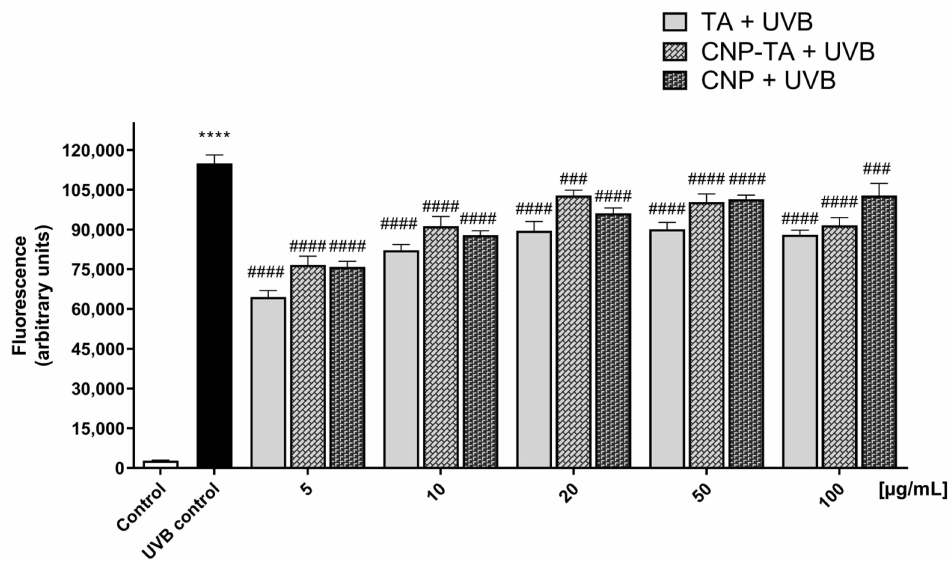
Figure 4. Evaluation of TA, CNP-TA and CNP treatments in the inhibition of reactive oxygen species (ROS) generation in L-929 fibroblasts. After 24 h treatment (5, 10, 20, 50 and 100 µ g/mL), cells were exposed to UVB, and ROS were detected immediately after irradiation. **** p < 0.0001 compared to the control, ### p < 0.001 and #### p < 0.0001 compared to the UVB control. Control: non-irradiated and untreated cells; UVB control: irradiated and untreated